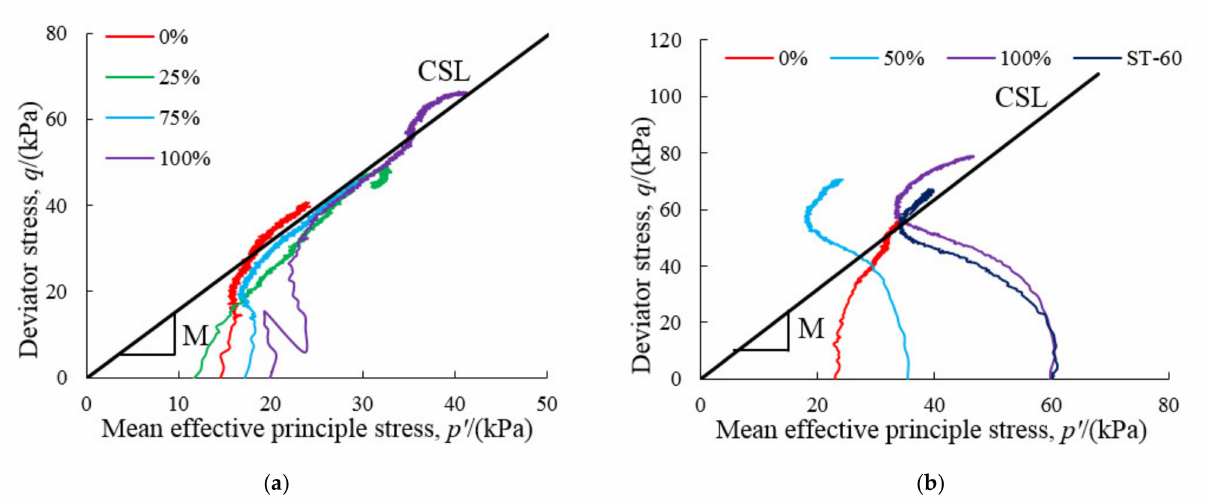
Figure 14. Effective stress paths of the soft soil with different degrees of reconsolidation ( n = 1000, CSR = 0.25): ( a ) p (cid:48) 0 = 20 kPa; ( b ) p (cid:48) 0 = 60